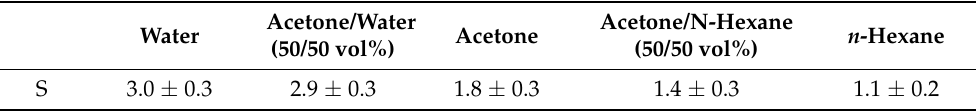
Table 2. Swelling ratio S of the PEGMA polymer resin determined in different solvents and solvent